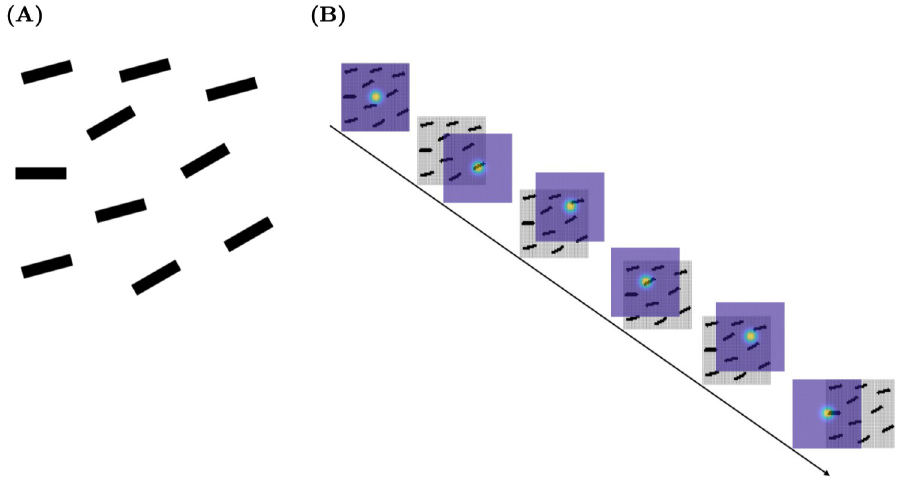
Fig 15. LAG-1 applied to an example visual search problem. A) Visual Field input array recreated from [53]. B) An example trial of LAG-1’s visual search scan path. Each frame is centered at the successive fixation location until the target is